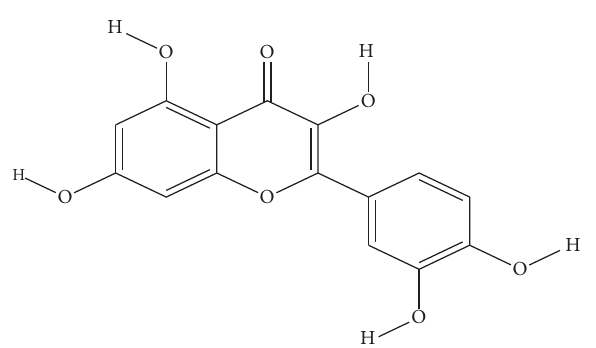
Figure 1: Chemical structure of